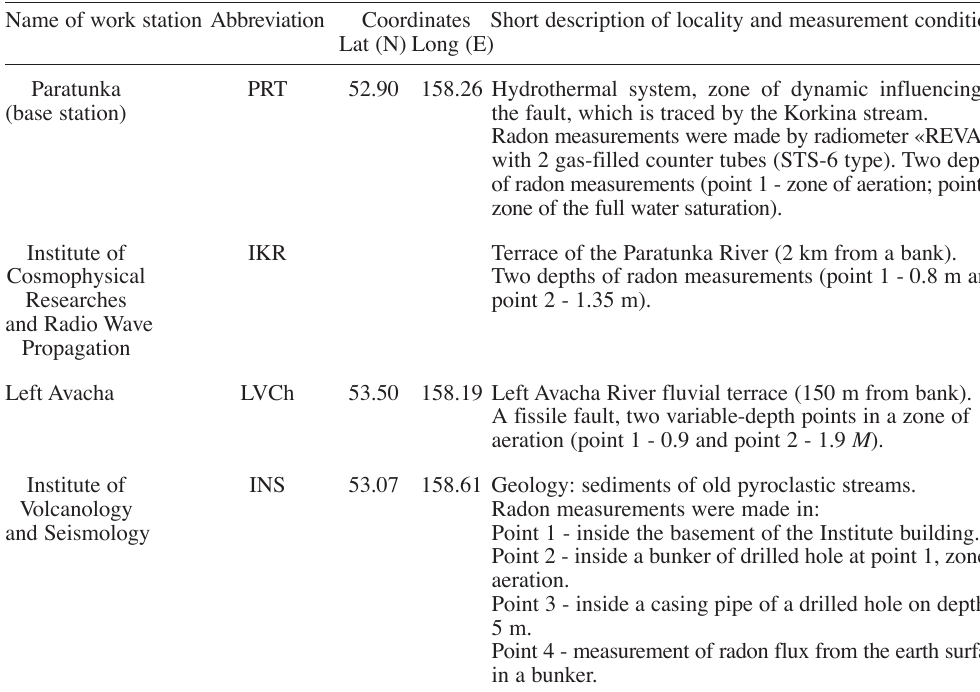
Table I. Coordinates of soil radon monitoring stations of Petropavlovsk-Kamchatsky geodynamic proving ground (July-August, 2004). Name of work station